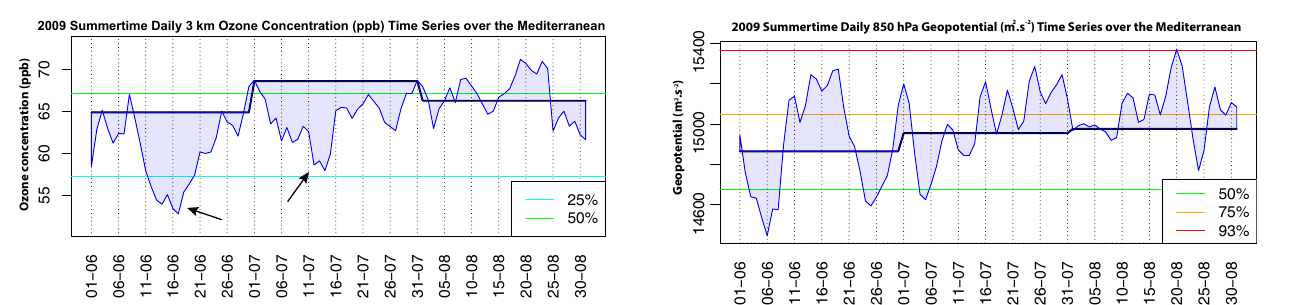
Figure 14. Same as Fig. 13 for 850hPa geopotential (m 2 s − 2 ) taken from the 12h ERA-Interim reanalysis.